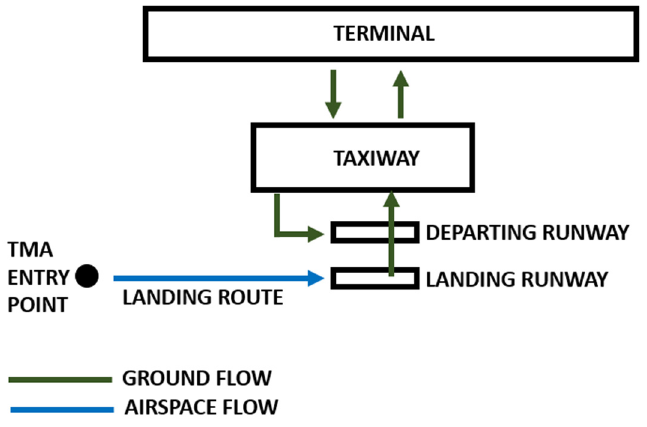
Figure 5. Schematic representation of the operations involved in the ACM.